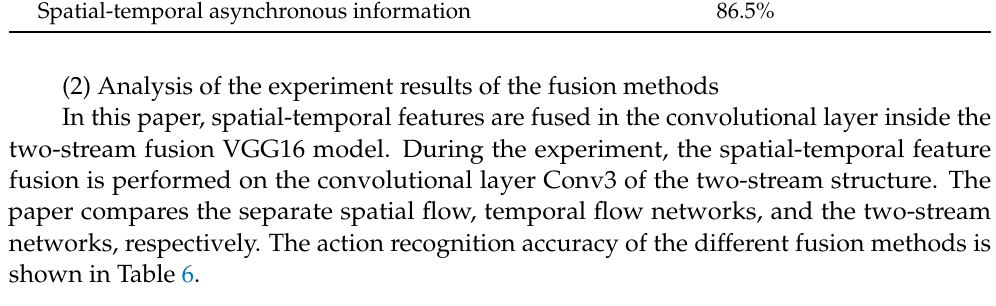
Table 6. Comparison of action recognition accuracy for different fusion methods.